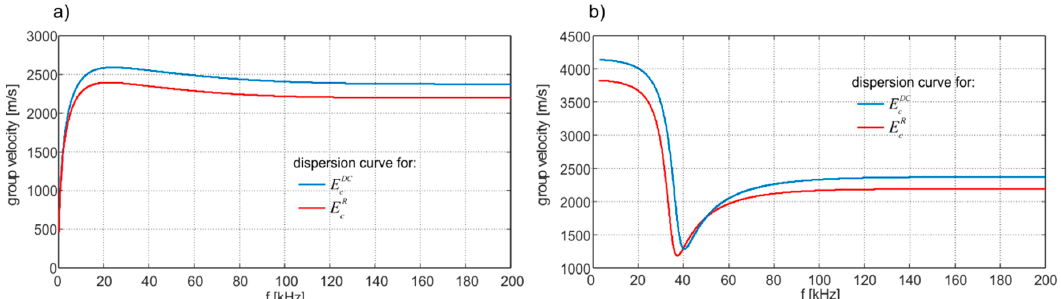
Figure 12. Comparison of ( a ) antisymmetric and ( b ) symmetric modes traced for various values of Young’s modulus.